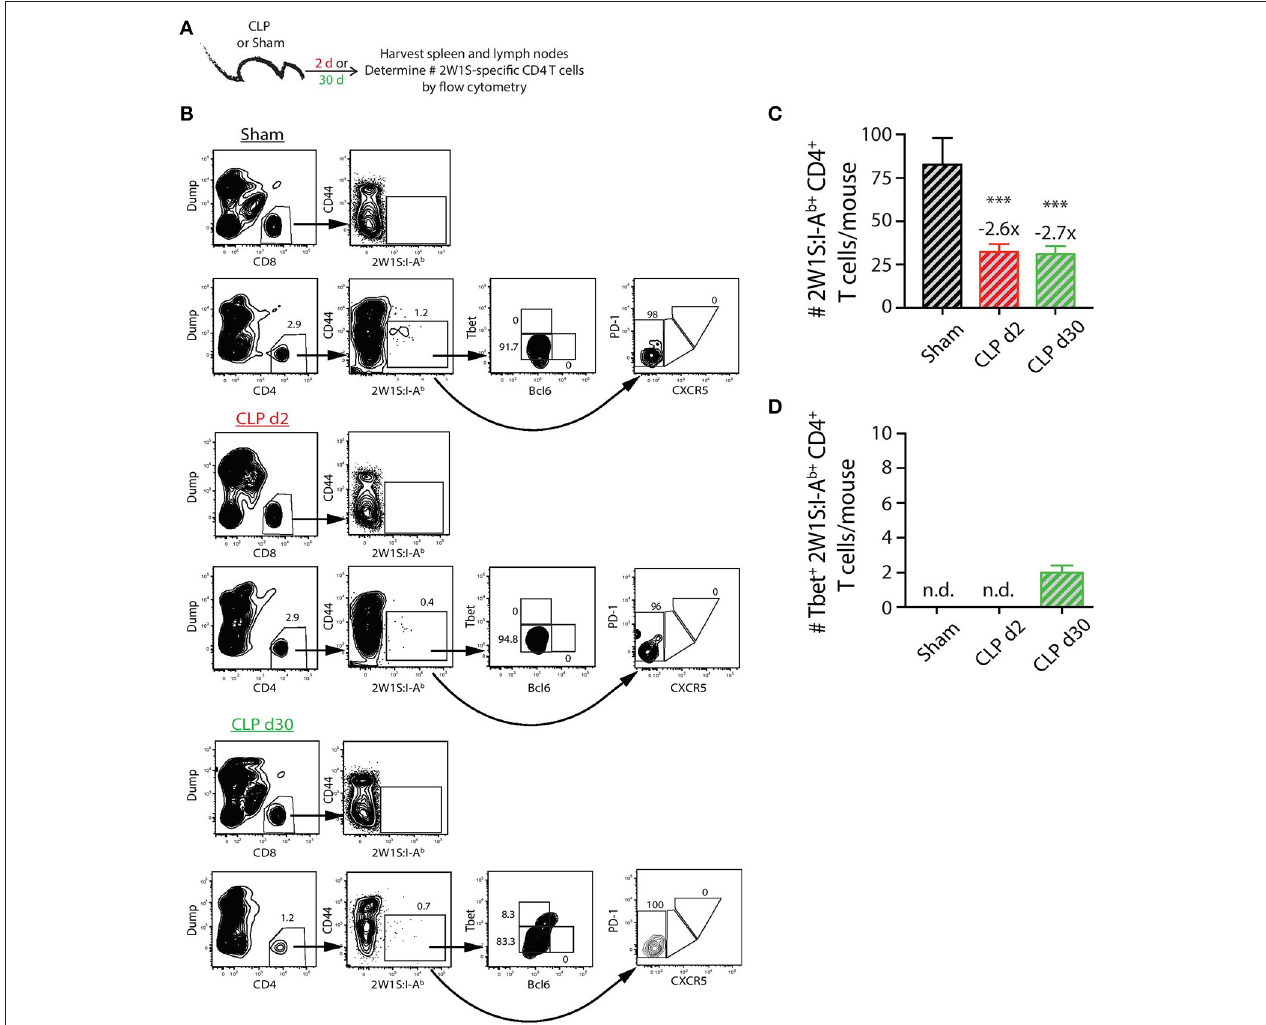
FIGURE 3 | Numerical changes in 2W1S-specific CD4T cells after sepsis. (A) Experimental design—Spleens and peripheral lymph nodes (axillary, brachial, cervical, inguinal, and mesenteric) were harvested from mice on day 2 and 30 post-sham or CLP surgery and combined. (B) Gating scheme used to identify 2W1S:I-A b -specific CD4T cells (CD8T cells were used as the internal negative control for tetramer binding), as well as the 2W1S:I-A b -specific CD4T cells expressing Tbet, Bcl-6, or PD-1 and CXCR5. The frequency of cells within the gated populations is indicated. The number of (C) total and (D) Tbet + 2W1S:I-A b -specific CD4T cells was determined. n = 9–10 mice/group in (B,C) . Statistical comparisons were made between sham mice and either CLP d2 or d30 mice, where *** p < 0.005. Numbers above bars indicate the average fold change in number compared to sham-treated mice.